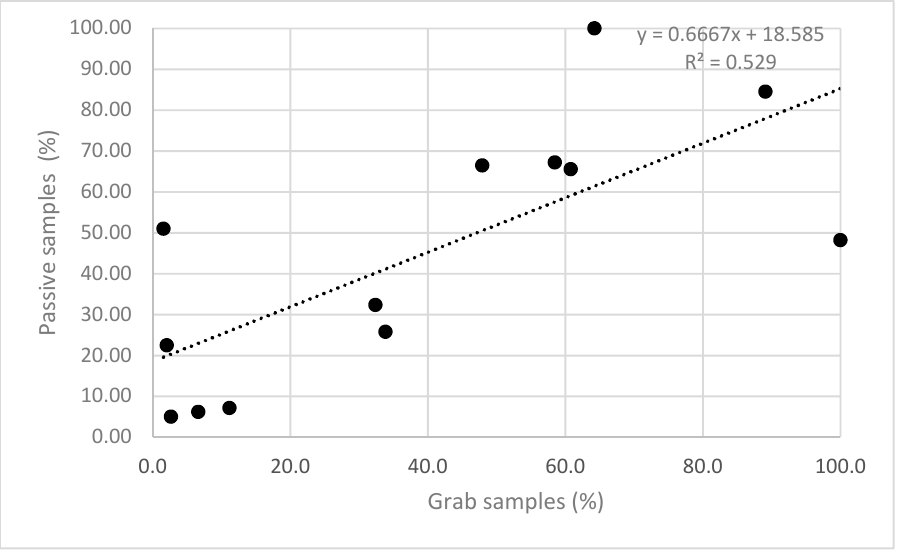
Figure 9. Linear dependence between the quantitative and qualitative determination of PCE.